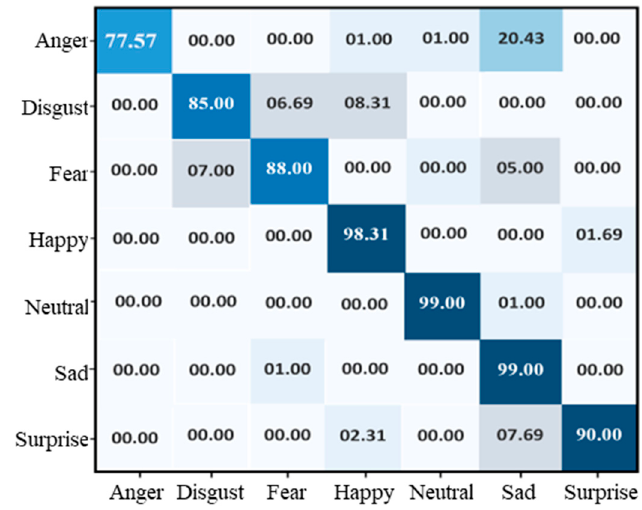
Figure 5. Training and validation of the proposed model over FER-2013: ( a ) accuracy and ( b ) loss.